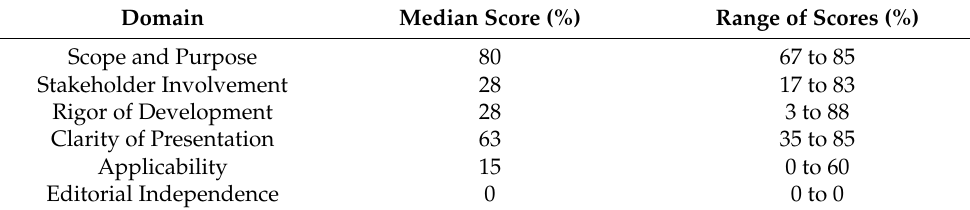
Table 3. Summary scores for each domain by the AGREE II tool. Domain Median Score (%) Range of Scores (%) Scope and Purpose